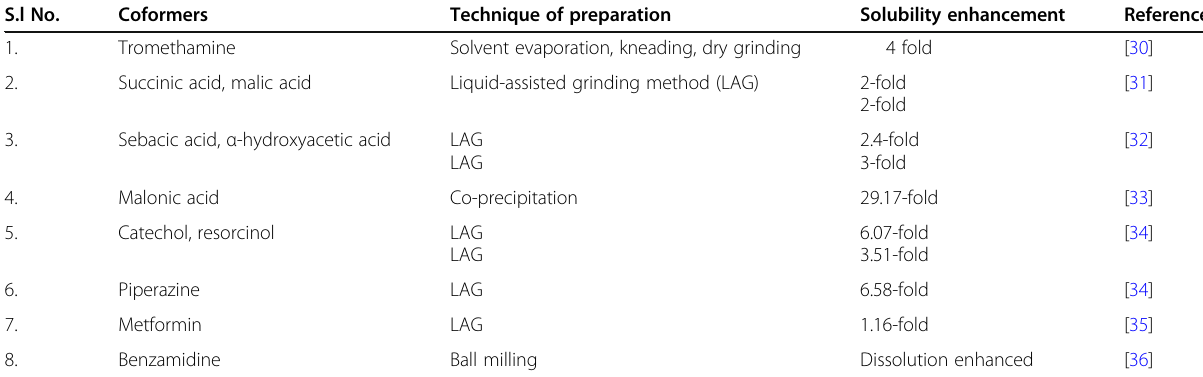
Table 1 Reported cocrystallization with gliclazide using different coformers S.l No.